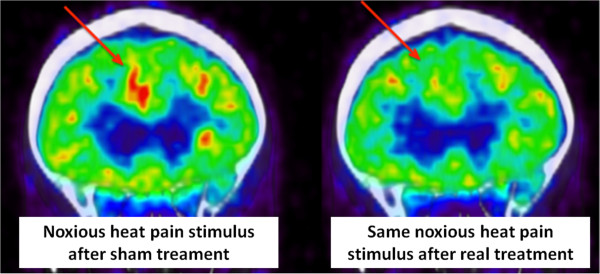
Three coil configurations used in the PET imaging study are displayed over standard EEG10-20 coil positions. Large circles represent the coils, and the arrows within represent the direction of the primary electrical current within that coil at the point of contact with the scalp. Note that all configurations have the same four geometric centers for each coil, but the coils are variously rotated so as to shape the magnitude and direction of the resulting magnetic field. The diagram is a planar representation of the curved head surface such that F3, F4 (lateral) and Fpz (anterior) positions are actually approximately vertical and at 90 degrees from the most posterior (“top” coil).